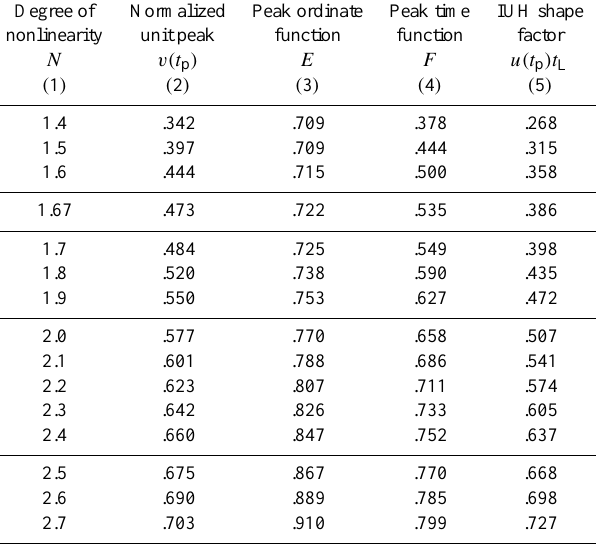
Table 1. Variable instantaneous unit hydrograph (IUH) shape